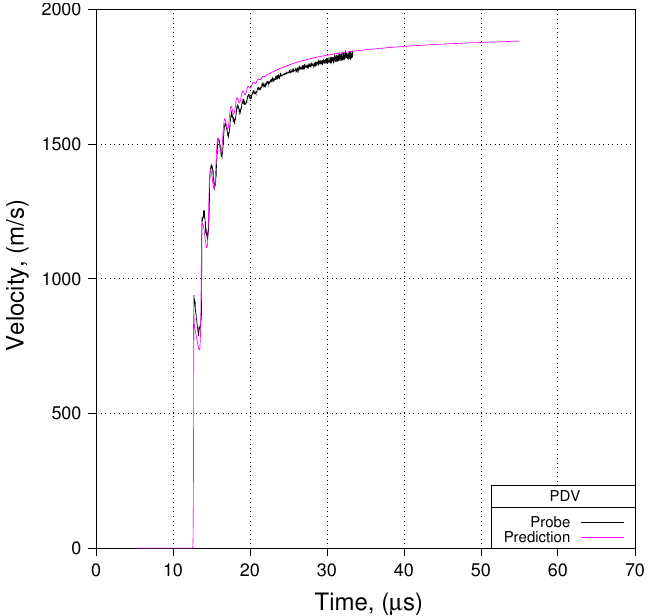
Figure 14. Prediction to Data: Shot 01, Probe 01,